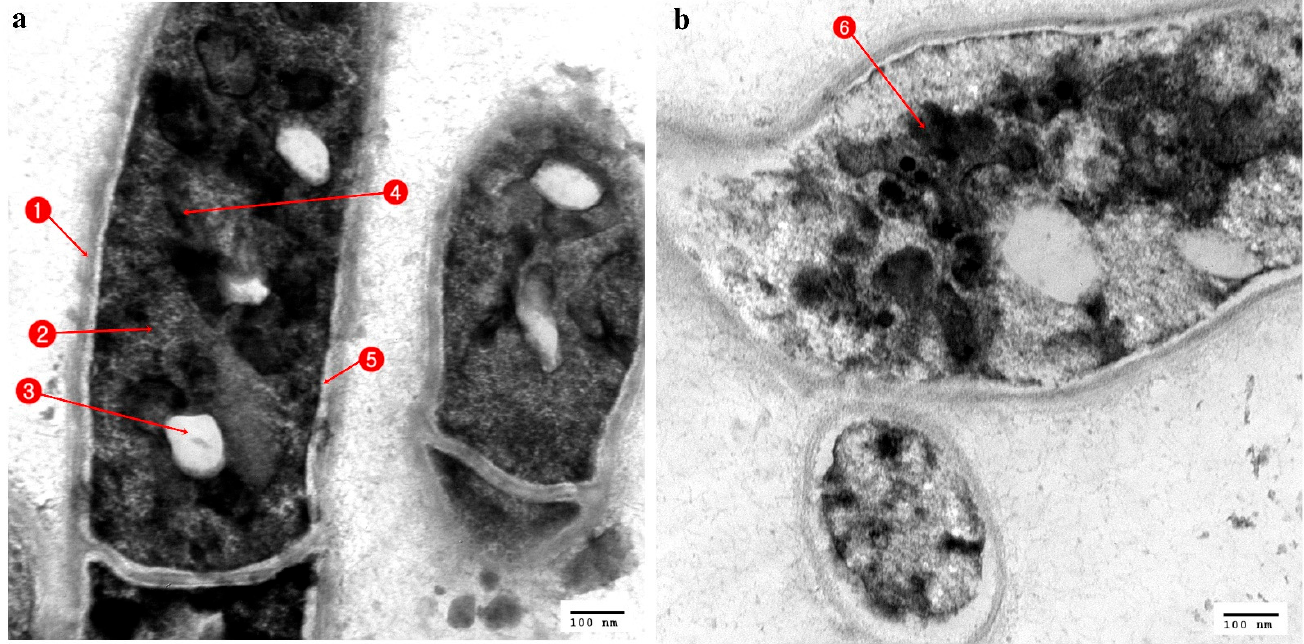
Figure 8. TEM micrograph of Penicillium italicum ; ( a ) Normal cells; 1. Cell wall; 2. Nucleus; 3. Vacuole; 4. Mitochondria; 5. Cell membrane; ( b ) cell affected with Delftia acidovorans ; 6. Nonhomogeneous cytoplasm.